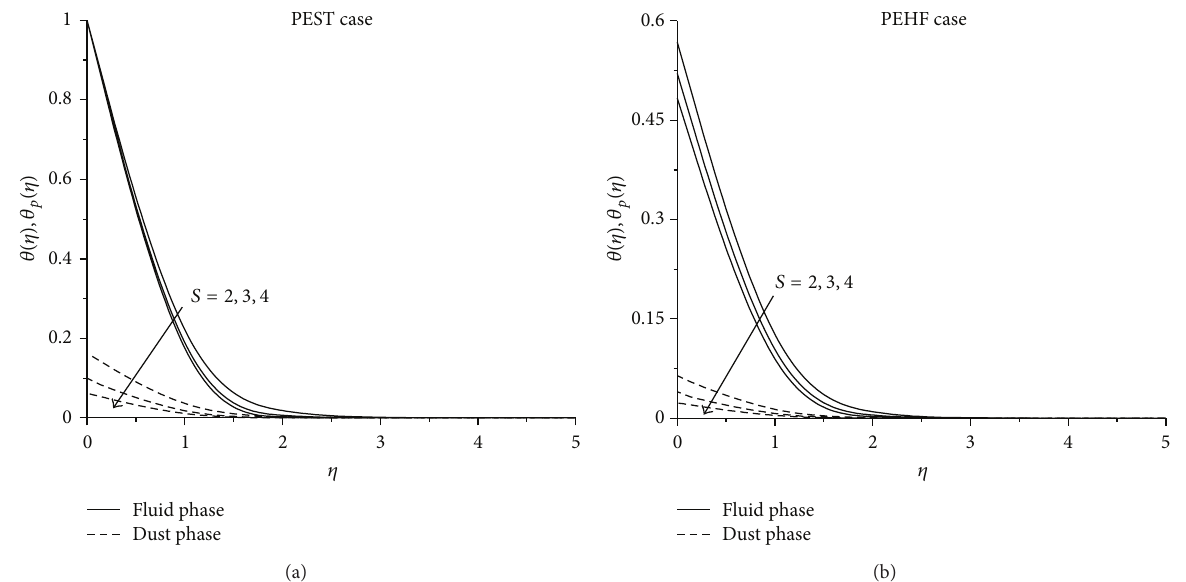
Figure 6: Effect of 𝑆 on temperature profiles for both PEST and PEHF cases with 𝑁 = Ec = 𝜆 = 0.5 , Pr = 0.72 , and 𝛽 = 0.6 .